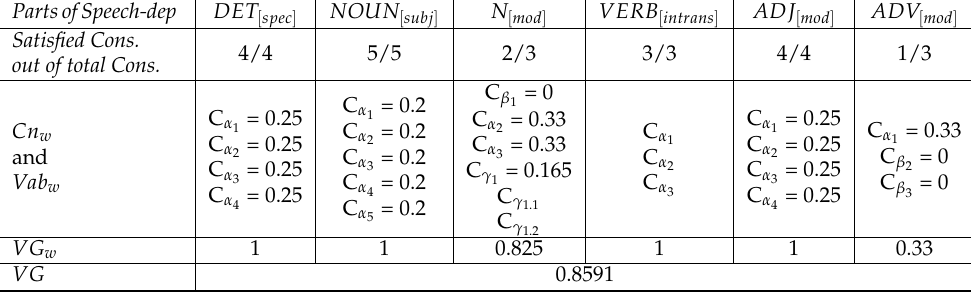
Table 7. Example of an input with values of grammaticality and its constraints. PartsofSpeech-dep DET [ spec ] NOUN [ subj ] N [ mod ] VERB [ intrans ] ADJ [ mod ] ADV [ mod ] Satisfied Cons. out of total